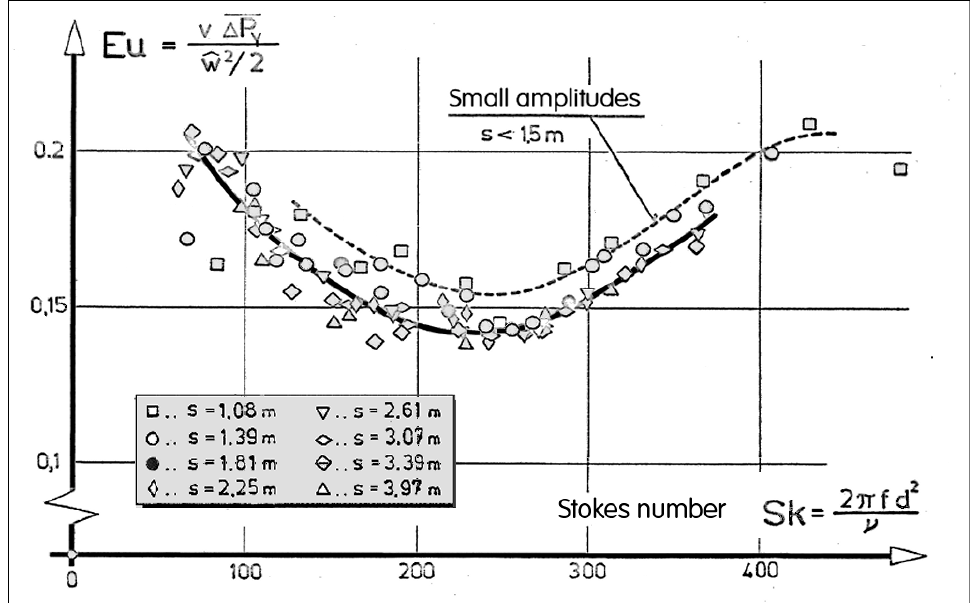
Figure 11. The universal law for the zero flow conditions in the rectifier, obtained by plotting the Euler number as a function of the Stokes number.